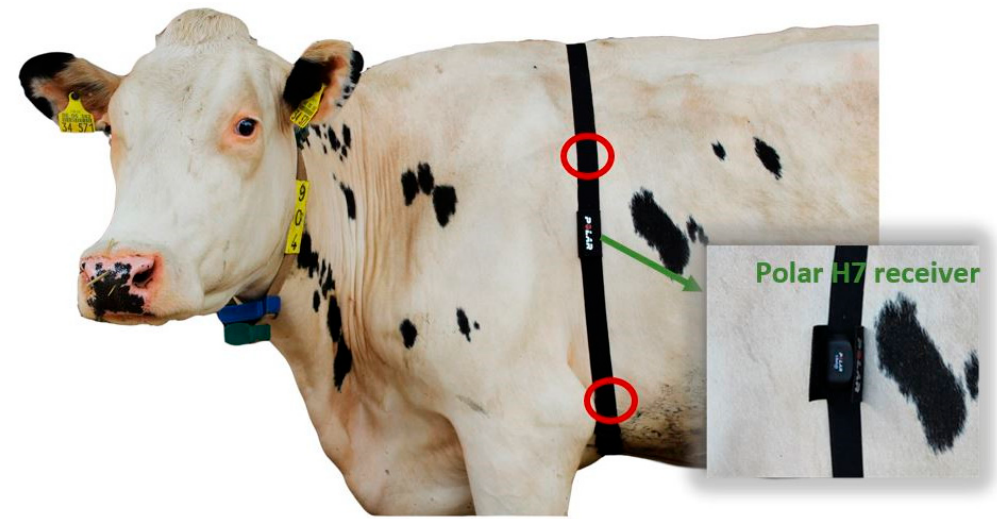
Figure 1. Dairy Cow I equipped with the Polar equestrian chest belt and Polar H7 receiver; red circles mark the placement of the electrodes.